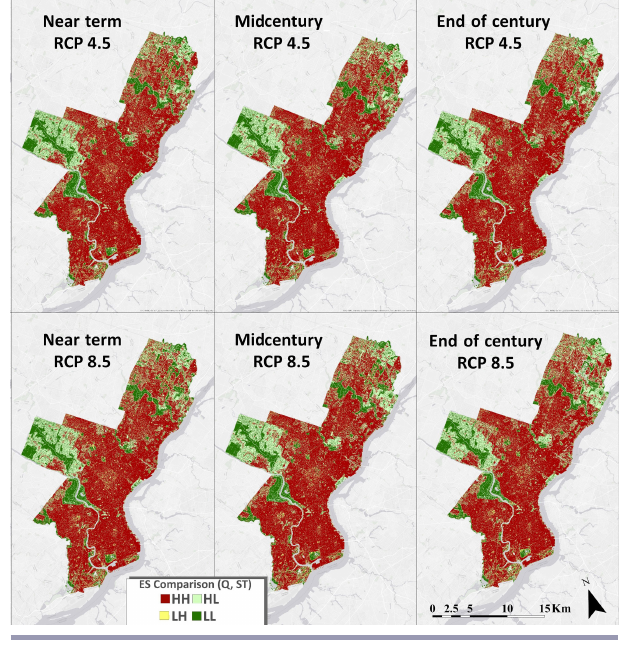
Fig. 5 . Comparison of predicted runoff (Q) and surface temperature (ST) regulating services over time under RCP4.5 and 8.5. High (H) measurements are above average and low (L) measurements are below average.